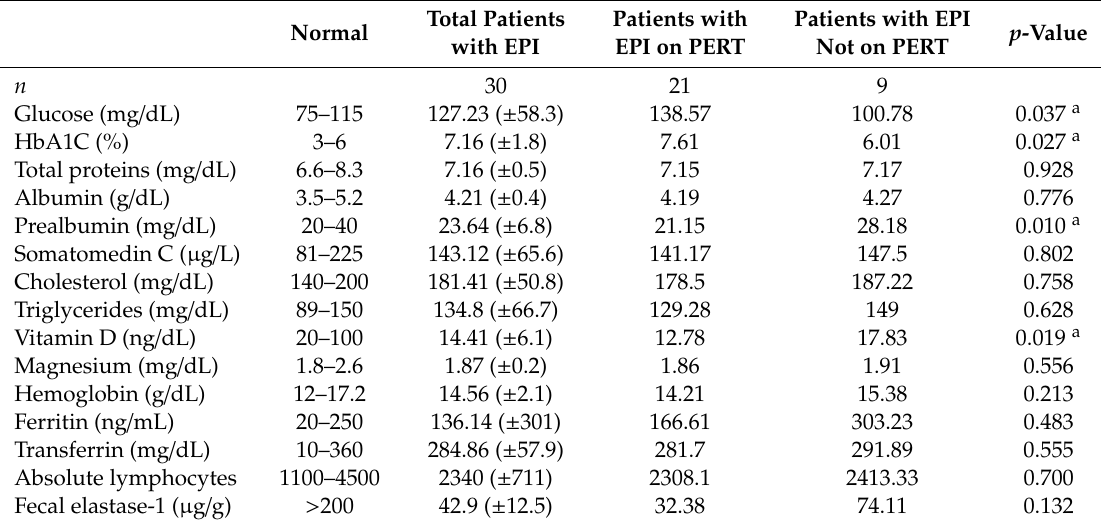
Table 5. Analytical parameters in patients with EPI on PERT and those not on PERT. Total Patients Patients with Normal with EPI EPI on PERT